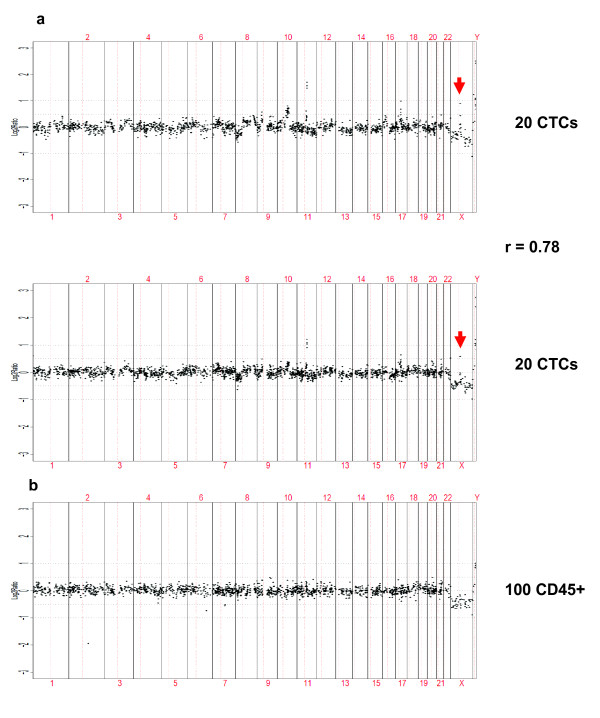
Copy number analysis of CTCs. Array comparative genomic hybridization analysis of (A) 20 CTCs in duplicate (B) and 100 leukocytes (CD45-positive) isolated from the same enriched blood sample from patient #9. The log2 ratio value for each BAC clone is plotted on the y-axis. The x-axis represents the genomic position of each BAC clone on the array, with chromosome numbers indicated. Vertical solid lines indicate chromosome boundaries, and vertical red dashed line represents the centromeric region dividing each chromosome into the p- or short arm (to the left of centromere) and the q- or long arm (to the right of the centromere). Arrows indicate high-level gains on X chromosome region containing AR.